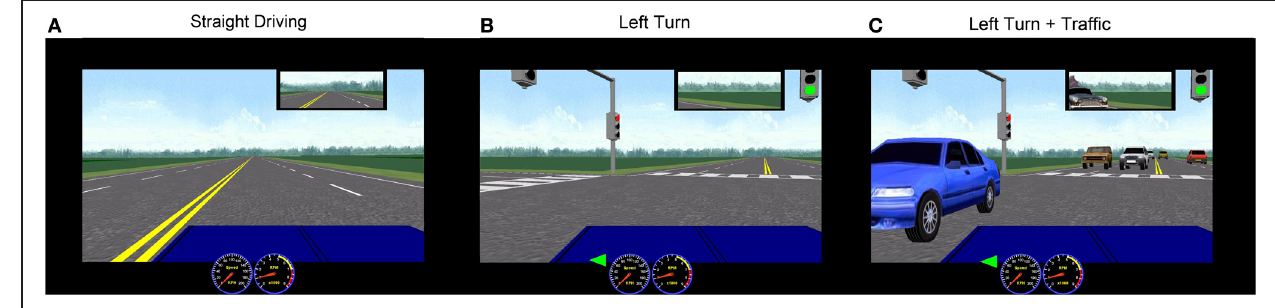
from using complex visual backgrounds. (A) Straight driving; (B) Left turn at intersection with no traffic; (C) Left turn with oncoming traffic.